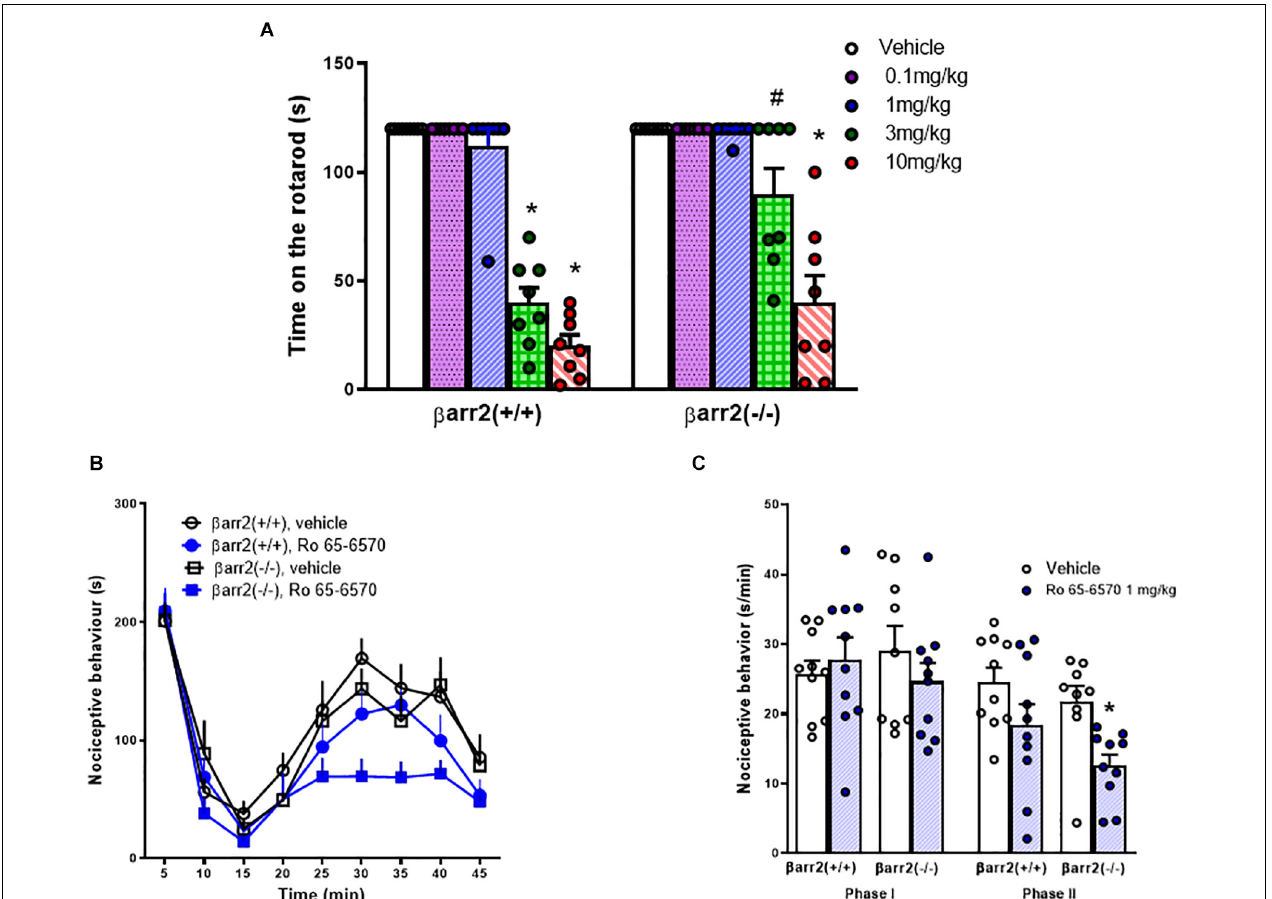
FIGURE 3 | Rotarod and formalin tests in C57BL/6J β arr2(+/+) and β arr2( − / − ) mice, effect of Ro 65-6570. (A) Time spent on the rotarod, each point represents the mean ± sem of 8 mice/group. Ro 65-6570 0.1–10 mg/kg, injected i.p. Two-way ANOVA treatment x genotype revealed an effect of treatment, genotype, and their interaction [ F ( 4 , 70 ) = 78.77, F ( 1 , 70 ) = 13.68, F ( 4 , 70 ) = 5.30]. (B) time course of formalin − induced pain behavior. (C) cumulative formalin − induced pain behavior during the I ◦ and II ◦ phases. Each point represents the mean ± sem of 10 mice/group. Ro 65-6570 1 mg/kg, injected i.p. Two-way ANOVA (treatment × genotype) revealed an effect of Ro 65-6570 in the second phase F ( 1 , 35 ) = 10.72. ∗ p < 0.05 vs. vehicle, # vs. β arr2( − / − ), Tukey’s